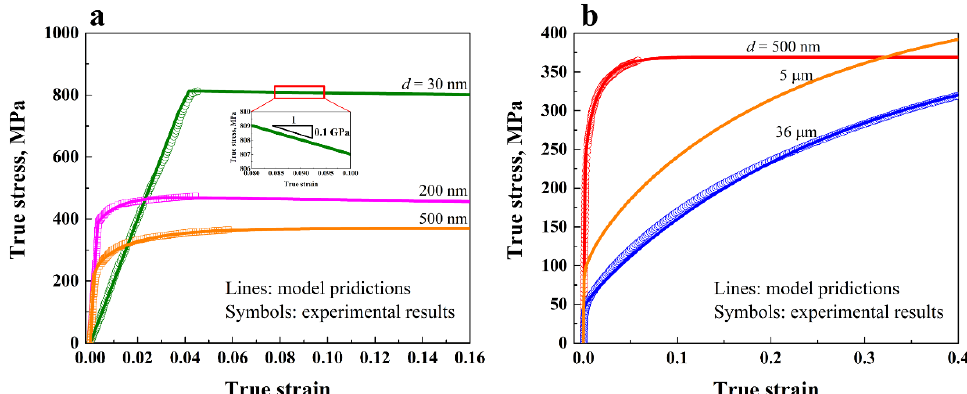
Figure 2. Comparison between model predictions and experimental results for true stress-strain curves of ( a ) NC Cu and ( b ) MC Cu. Inset in ( a ) shows the linear softening in the NC region.